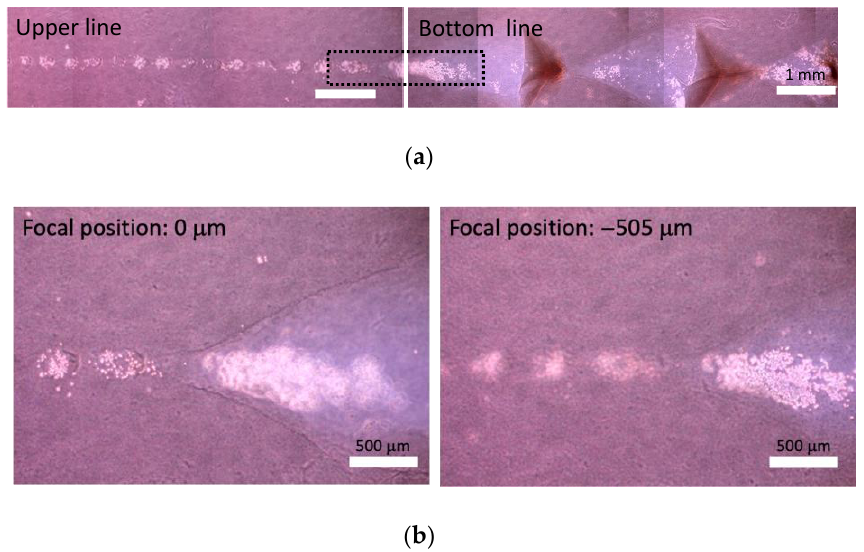
Figure 5. Phase-contrast images of straight lines at different depth in native collagen gel. ( a ) Gross images of upper and bottom lines, ( b ) enlarged images at different focal positions indicated by dashed line in the gross image.